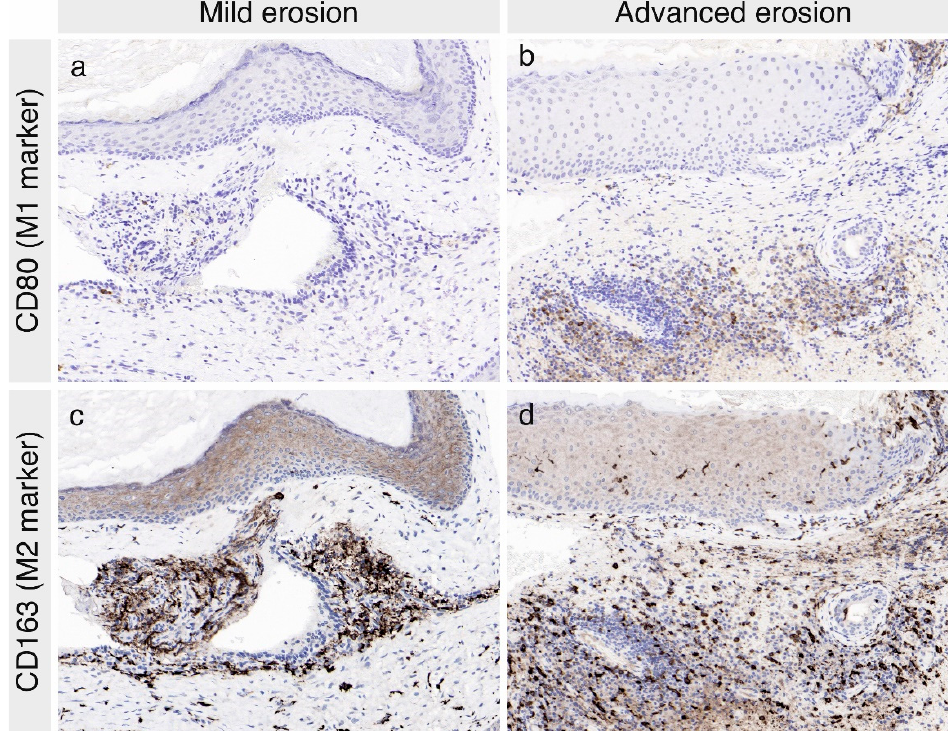
Figure 3. Paraffin section of a representative cholesteatoma specimen with mild erosion (o0 specimen with an intact ossicular chain) and a specimen with advanced erosion (o3) stained for the M1-marker CD80 and the M2-marker CD163. The number of CD80+ cells (M1 macrophages) was higher in the specimen with advanced erosion ( b ) compared to that with mild erosion ( a ). The number of CD163+ M2 cells was much higher than that of M1 cells in both specimens (( a , b ) compared to ( c , d )) without significant differences between the specimens with mild ( c ) or advanced erosion ( d ).